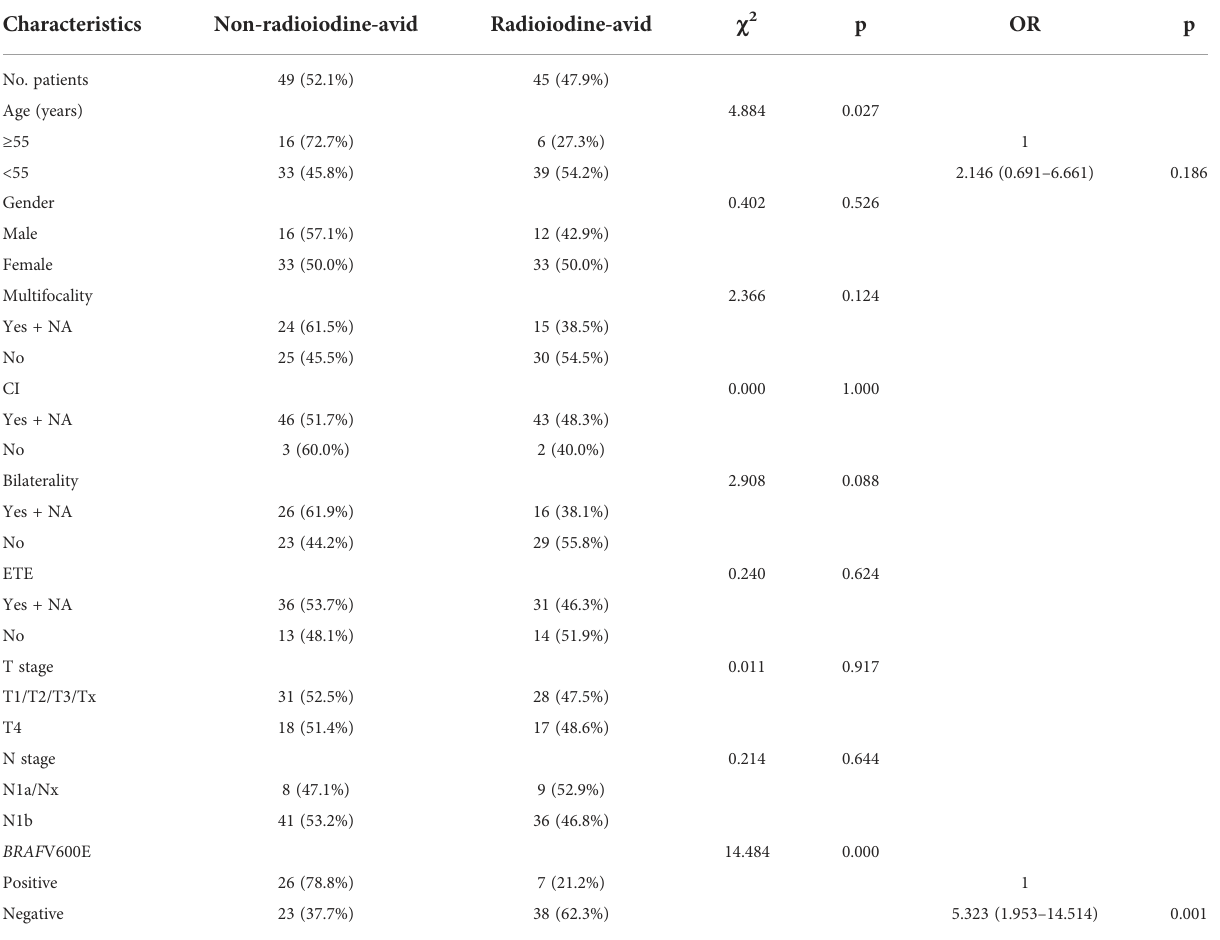
TABLE 2 The relationship between clinical features and the loss of radioiodine avidity.